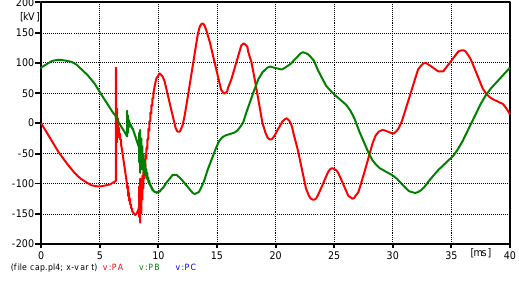
Fig. 27. Primary side